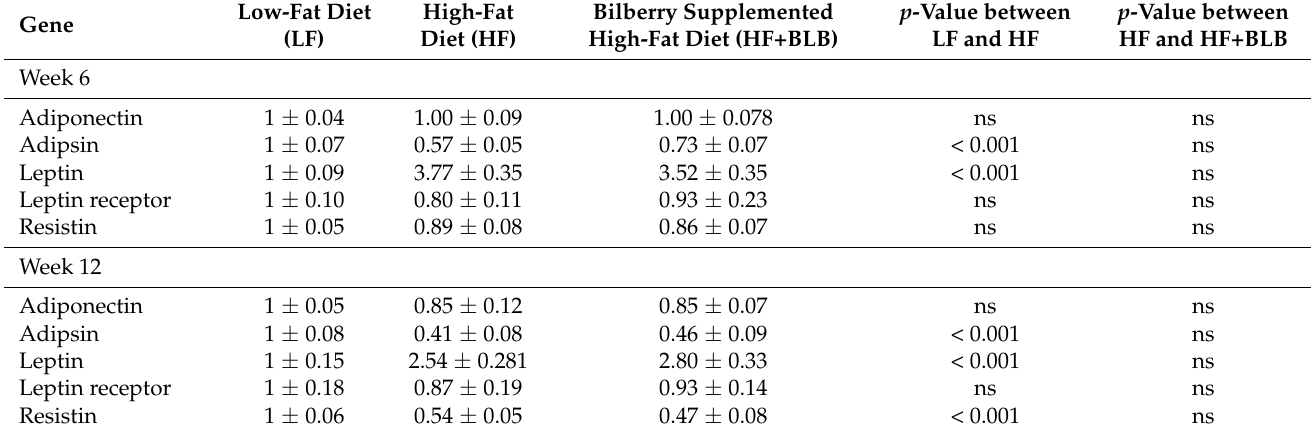
Table 3. The expression of adipokines in epididymal fat tissue. The mice received a low-fat diet (LF, 10% energy from fat), a high-fat diet (HF, 46% of energy from fat) or a bilberry-supplemented high-fat diet (HF+BLB, 20% air-dried bilberry powder) for six or twelve weeks. The gene expression was measured with RT–PCR and normalized against the housekeeping gene glyceraldehyde 3-phosphate dehydrogenase ( Gapdh ). The expression levels were then compared to the mean expression level of the LF group. The results are expressed as a fold change and analyzed with a one-way ANOVA and a Bonferroni multiple comparisons test. Values represent mean ± SEM; n = 12 mice in each group; ns = not significant ( p >